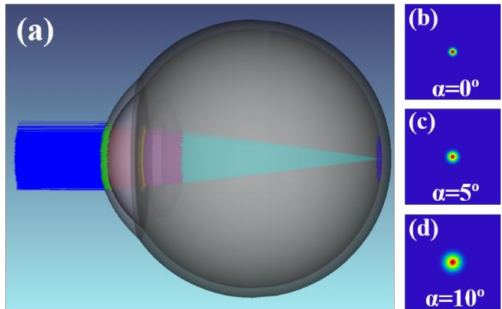
Figure 6. Shaded representation of the IS eye model. ( a ) Retinal projection of an incident collimated Gaussian beam of the IS -free eye. ( b ) Cataract modelled eye with α = 0 ◦ . ( b ) α = 5 ◦ ( c ) and α = 10 ◦ . ( d ) Glare angles.